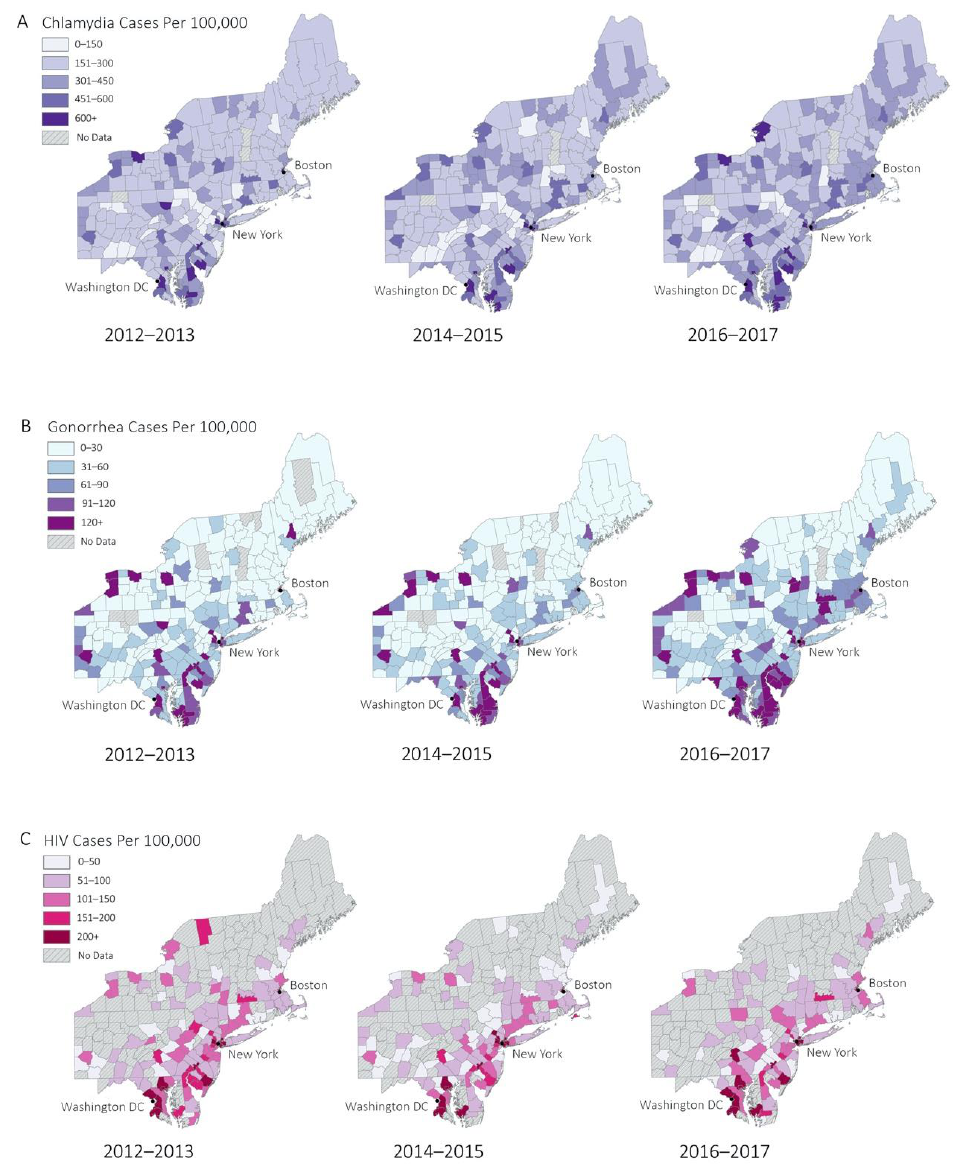
Figure 2. ( A – C ). Geographic distribution of dependent variables over all time windows. ( A ) Chlamydia cases per 100,000, ( B ) gonorrhea cases per 100,000, ( C ) HIV cases per 100,000. Colored regions on map represent county-level data. Counties with no data (either unrecorded or suppressed due to low case counts) were given a neutral (gray) color. Low rates of sexually transmitted infection are represented by lighter tones, while high rates are represented by darker tones.